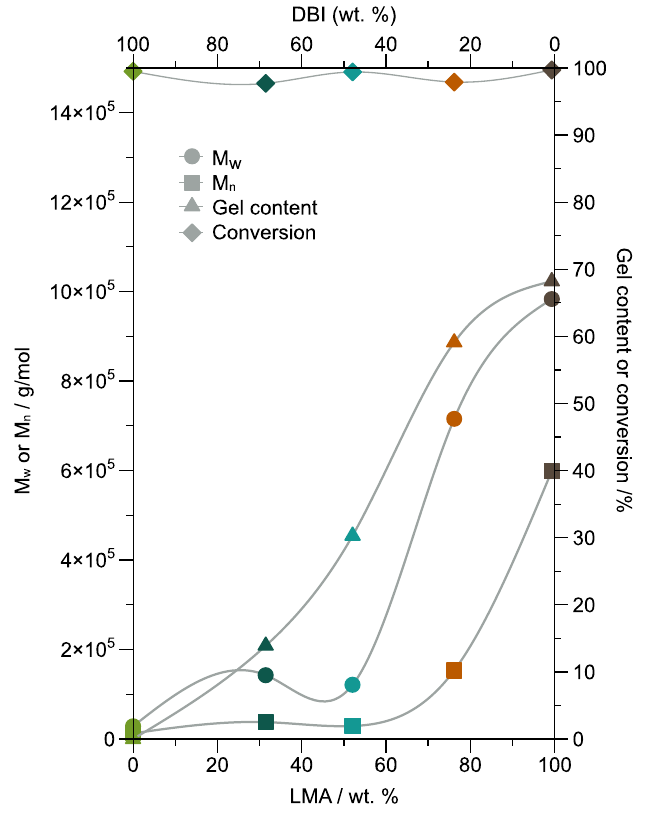
Figure 4. Graph of M w (weight average molecular weight), M n (number average molecular weight), gel content, and conversion values of the PSA-1000, PSA-2000, PSA-3000, PSA-4000, and PSA-5000 samples.